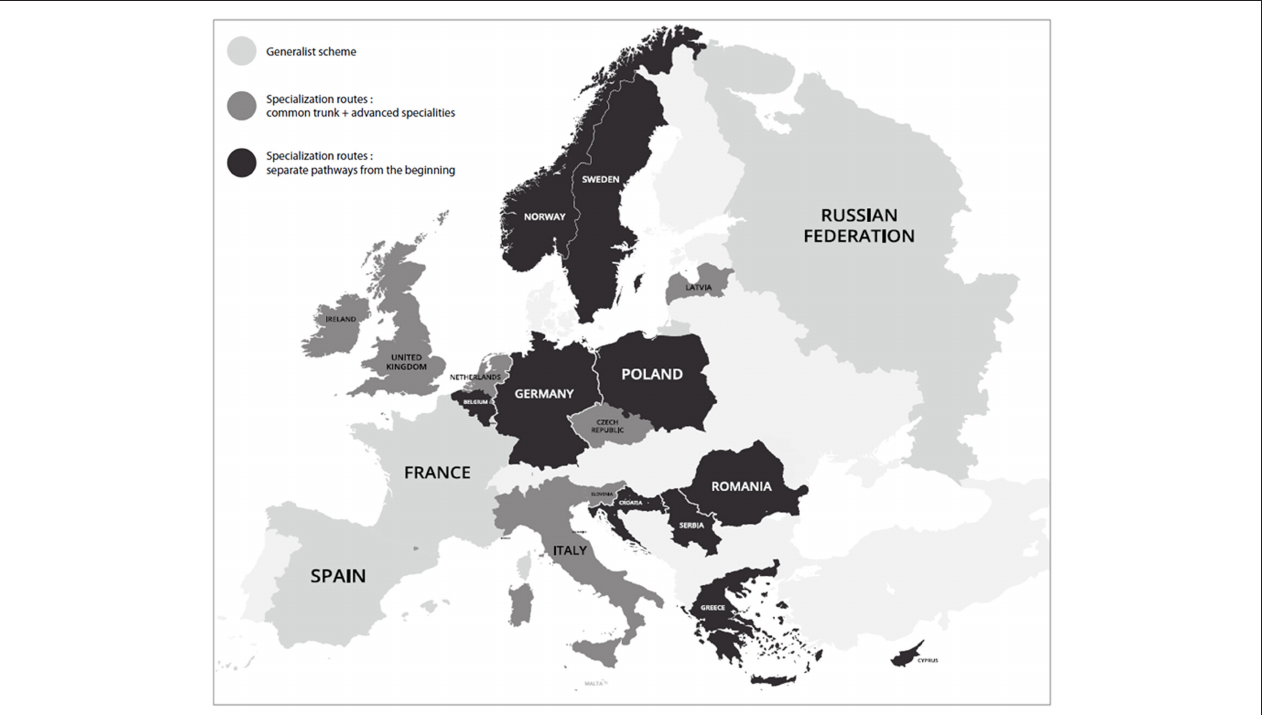
FIGURE 1 | Mapping of the 3 training